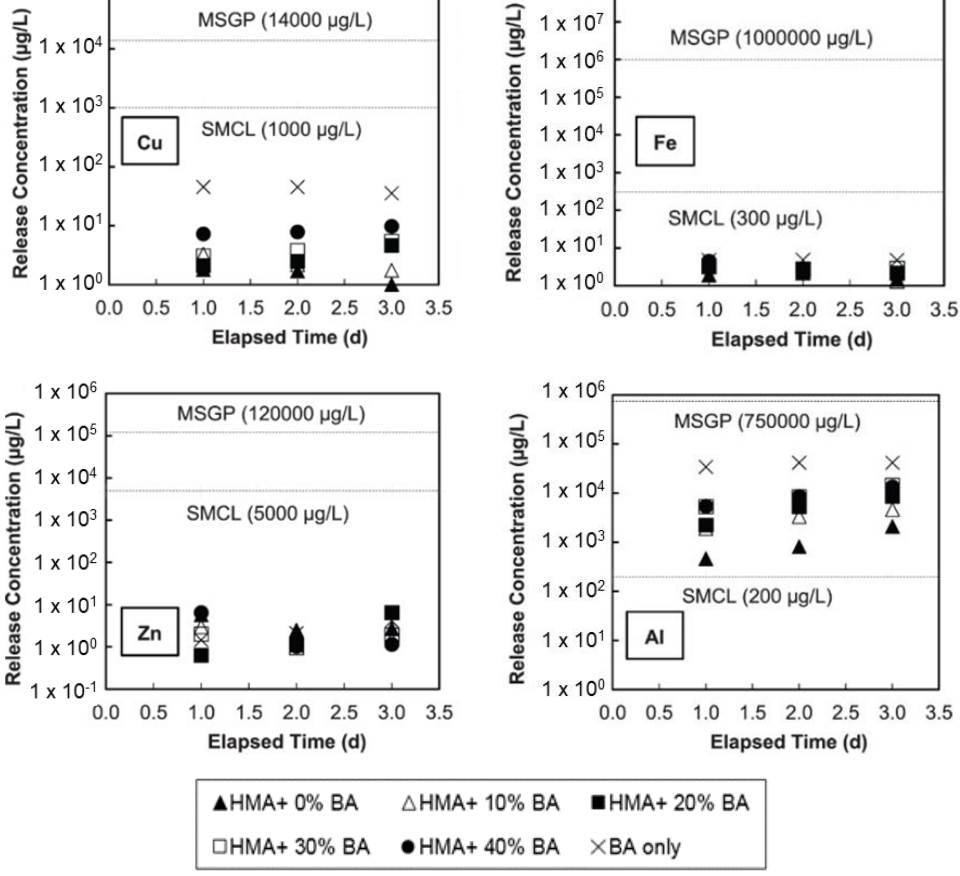
Figure 5. Leaching concentrations of priority elements, including Cu, Fe, Zn, and Al, from HMA containing BA compared with the SMCL and MSGP criteria [196].